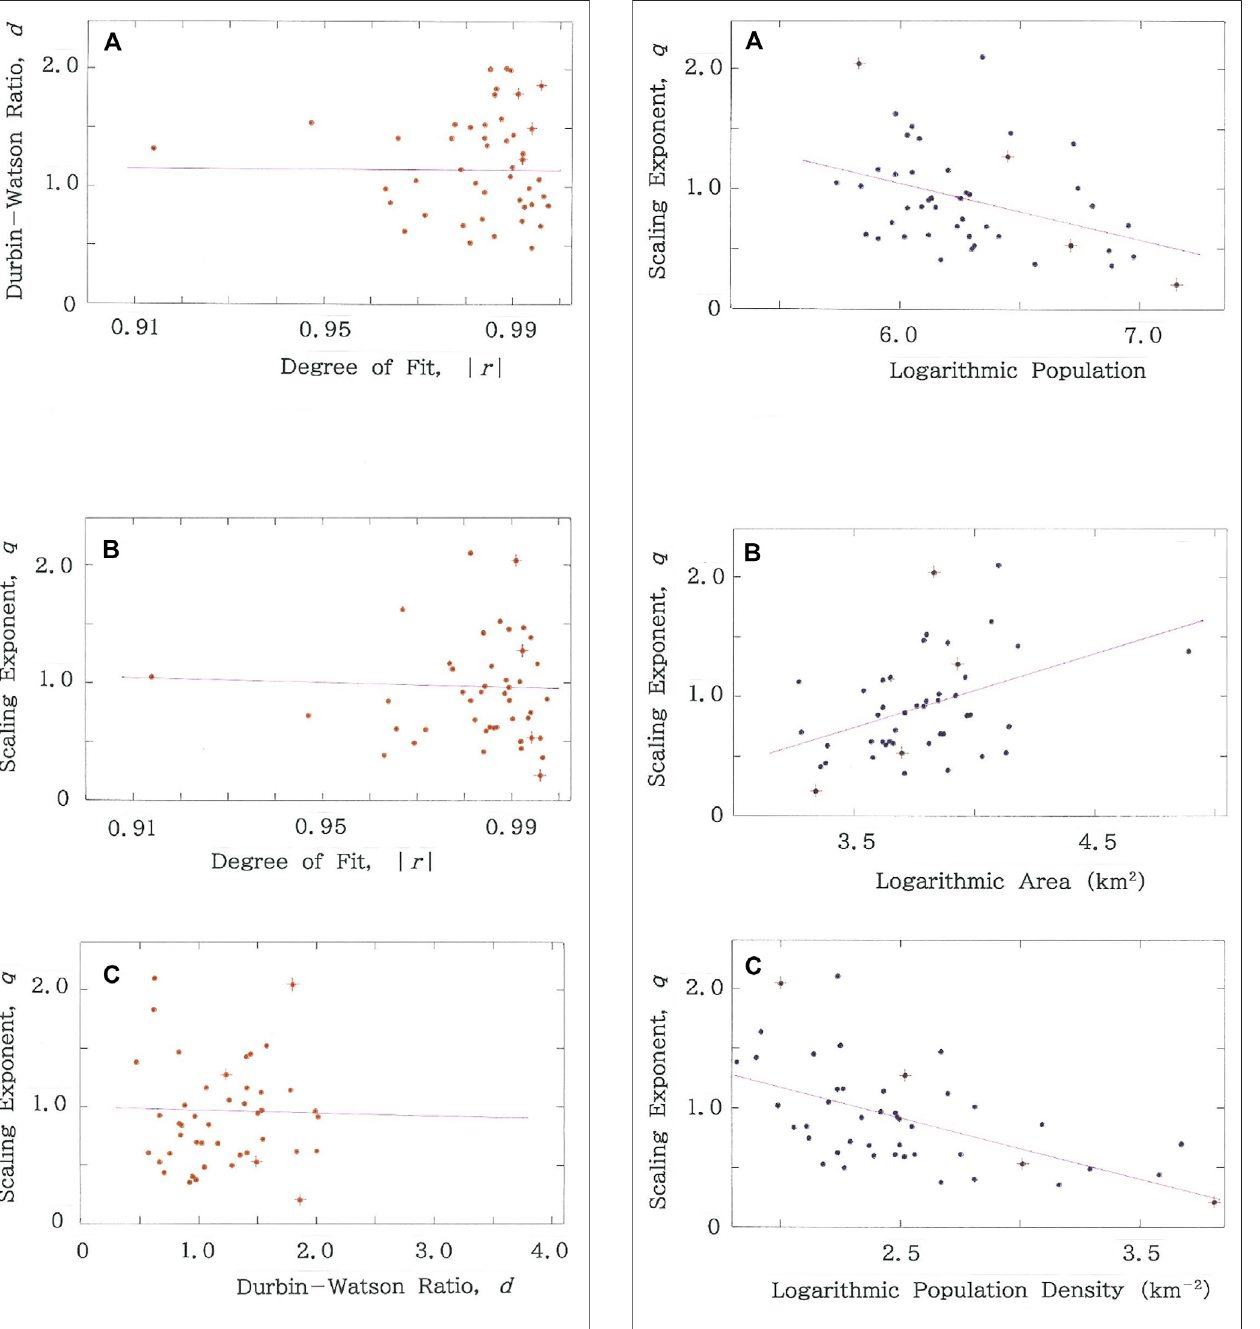
FIGURE4| Dependenceofscalingexponent, q ,onthegeographicdata of the entire prefecture in Japan. The purple line in the individual cross section indicates the regression line. The red crosses that are superimposed on the dots highlight the four prefectures in Tables 2 and 3 . (A) q vs. common logarithm of population. (B) q vs. common logarithm of area (km 2 ). (C) q vs. common logarithm of population density (km − 2